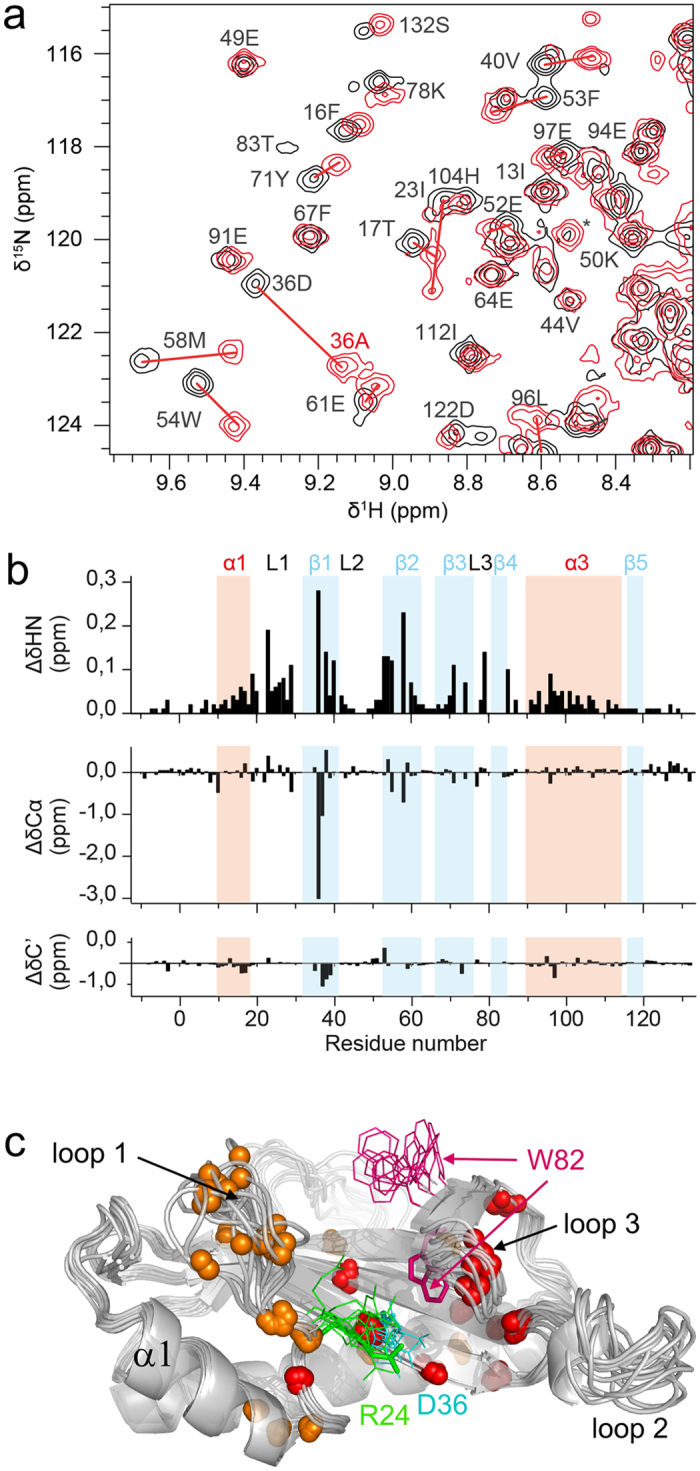
Structural analysis by NMR of the D36A CrlSTM mutant.(a) Selected region of assigned 1H-15N HSQC spectra of 13C15N-labeled D36A (red) and wild-type (black) CrlSTM displaying chemical shift perturbations due to the D36A substitution. Red lines link D36A to the corresponding wild-type CrlSTM signals. (b) Plot of combined 1H15N amide and 13Cα and 13C’ backbone CSPs as a function of residue numbers in CrlSTM. Secondary structures are indicated by background coloring (red for α-helices and blue for β-strands) and annotated on top. Loops are denoted by the letter L. (c) Mapping of amide CSPs on a cartoon representation of an NMR ensemble structure (10 conformers) of CrlSTM. Nitrogen atoms are shown by red and orange spheres for residues with ΔδHN > 0.1 ppm and >0.05 ppm, respectively. The side chains of R24, D36 and W82 are shown as lines in green, cyan and magenta, respectively. The corresponding side chains of a model built from the X-ray structure of CrlPM (PDB 4Q11) are indicated in sticks with the same colours.